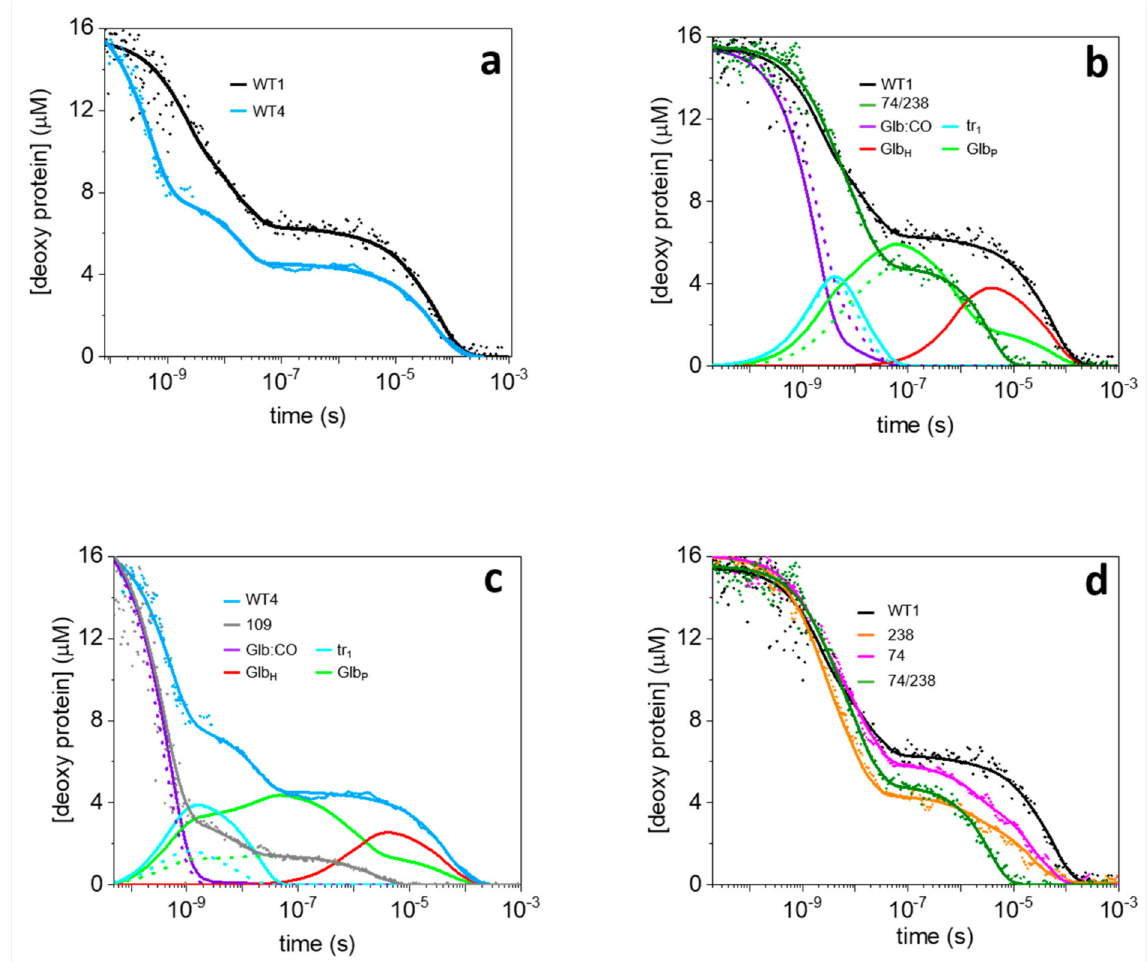
Figure 3. Analysis of the complete course of CO rebinding kinetics to WT1, WT4 and their mutants. The progress curve for the CO rebinding reaction after the hybrid pump–probe experiment is plotted as concentration of deoxy heme versus time. ( a ) Comparison between WT1 and WT4. The experimental data are superimposed on the fitted curves obtained using Scheme 1. ( b , c ) Replacement of His d by Leu affects the time evolution of the CO rebinding kinetics, as demonstrated by the comparison between WT1 and its mutant 74/238 in ( b ) and between WT4 and its mutant 109 in c . The fitting curves are superimposed on the experimental data (circles). In ( b , c ), the time courses of the other relevant species are shown using the same color code as for the kinetic model reported in Scheme 1. ( d ) Comparison between the kinetics of WT1 and its 74, 238 and 74/238